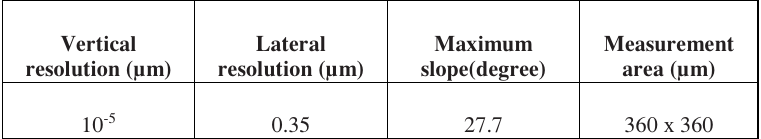
Table 1. Specification of TALYSURF CCI 6000 corresponding to 50x